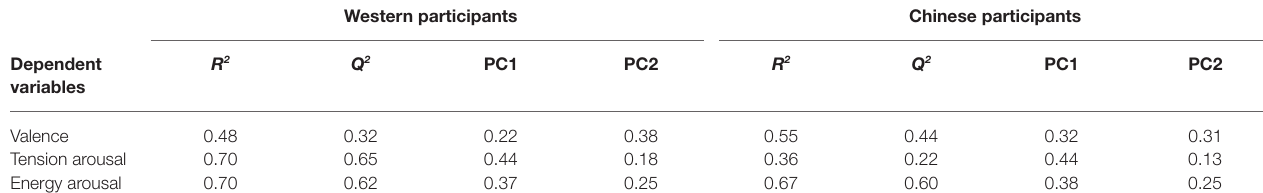
TABLE 4 | R 2 and Q 2 results for partial least squares regression (PLSR) models for predicting perceived valence, tension arousal, and energy arousal, as well as component-wise contributions along the two principal components